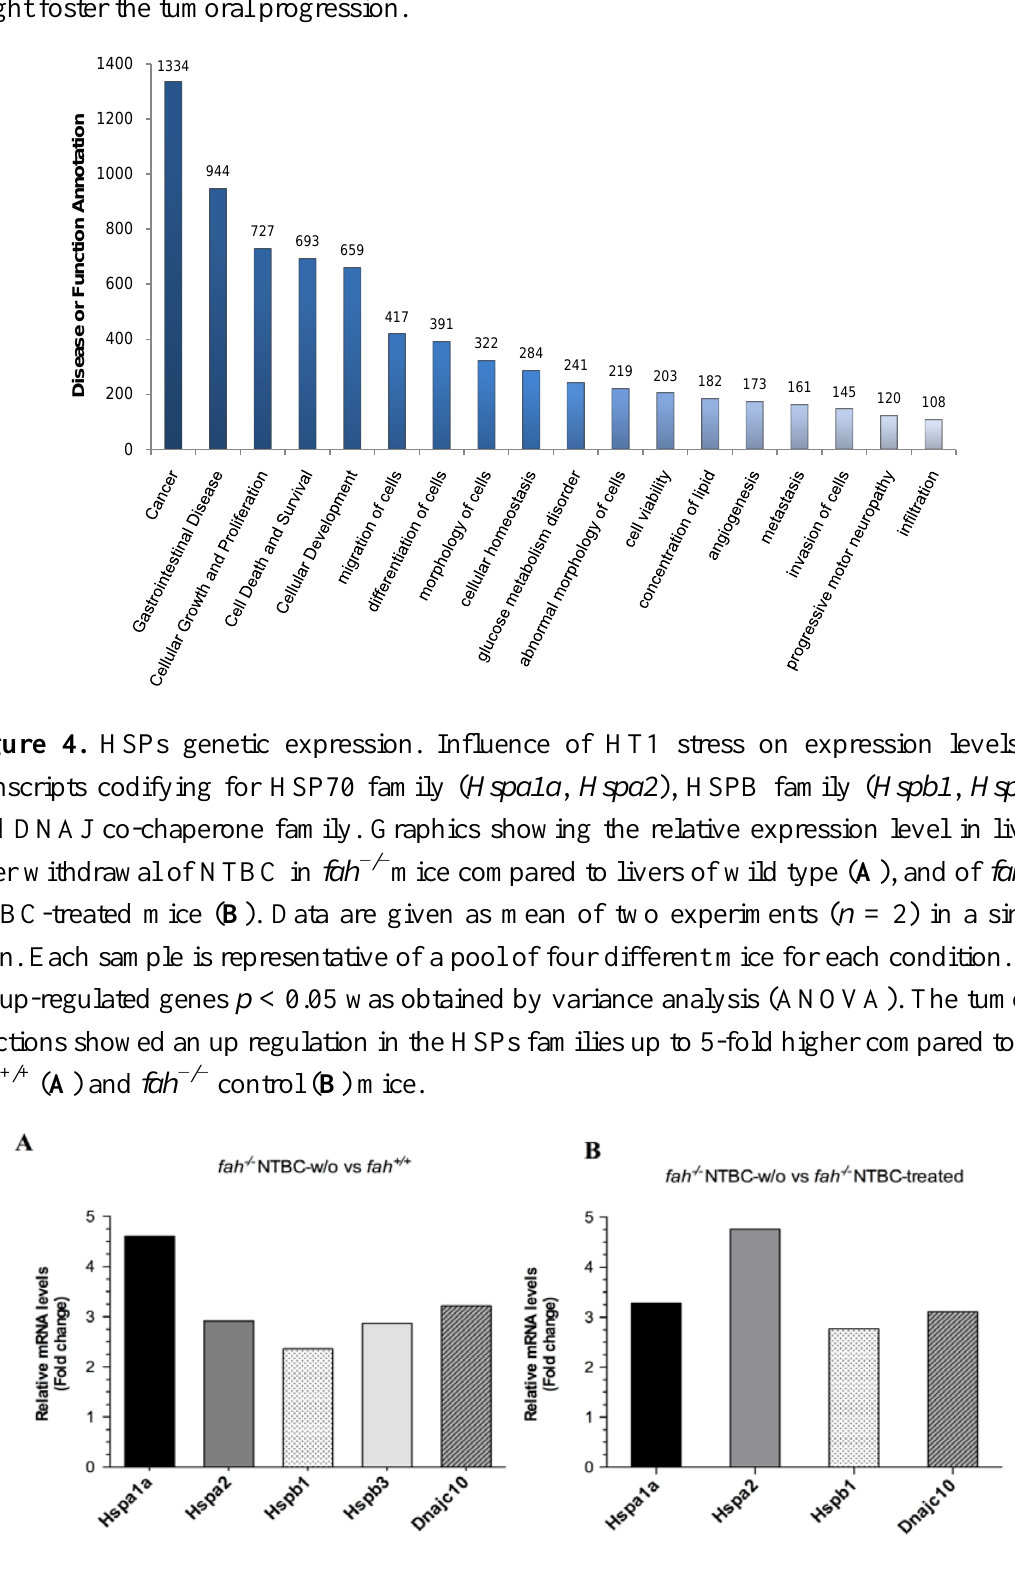
Figure 3. Disease and function annotation according to IPA software. As it can be noticed the largest amount of deregulated genes is involved in the mechanism of cancer. Others relevant processes are those implicated in gastrointestinal disease, cellular growth and proliferation, migration and differentiation of cells. These evidence suggest that under HT1 stress there is a wide gene regulation involving many biological processes that all together might foster the tumoral progression.